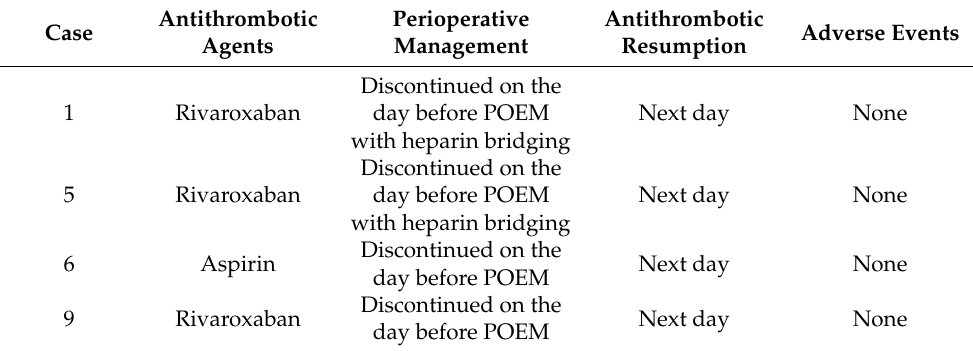
Table 3. Perioperative management of the patients taking antithrombotic drugs.